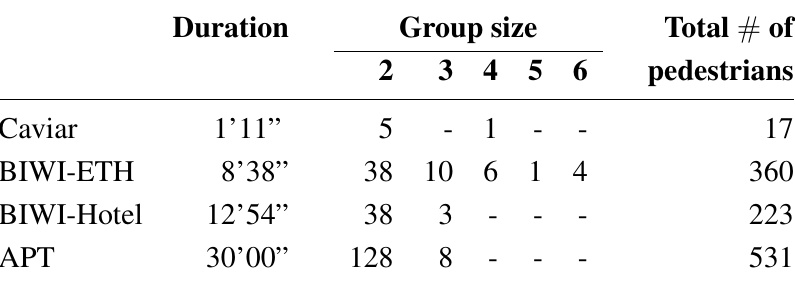
Table 1. Specifications of